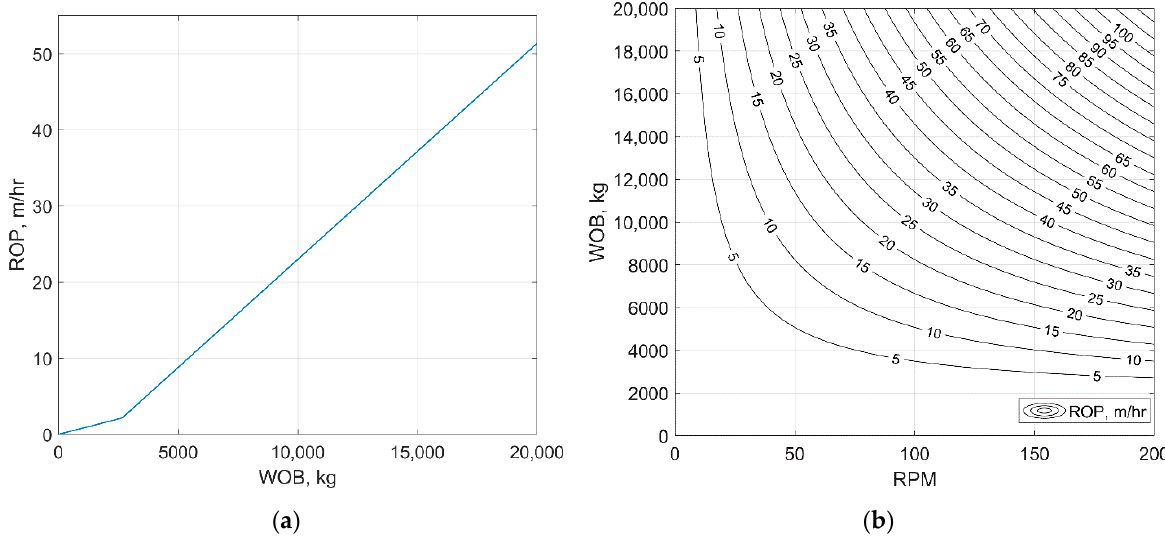
Figure 1. Drilling response in phase I and phase II of the Detournay model [28] for a 12 ¼” bit drilling in the generic formation A . ( a ) ROP as a function of WOB for a constant RPM value of 90; ( b ) Contour plot of ROP (m/h) as a function of applied WOB and RPM .